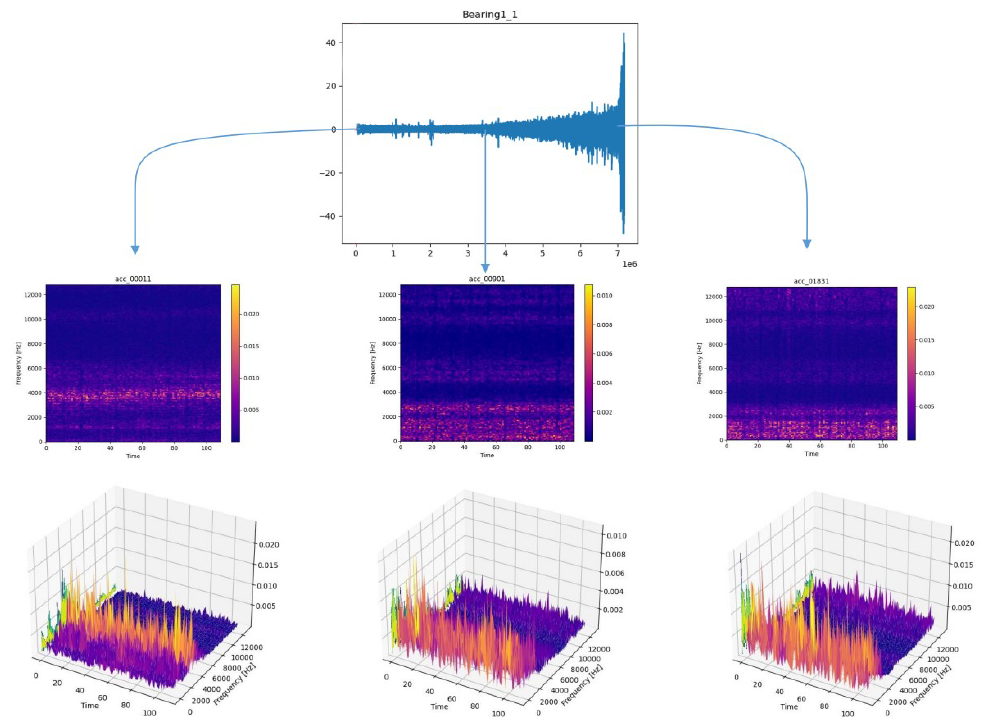
Figure 4. Three stages of vibration signal.